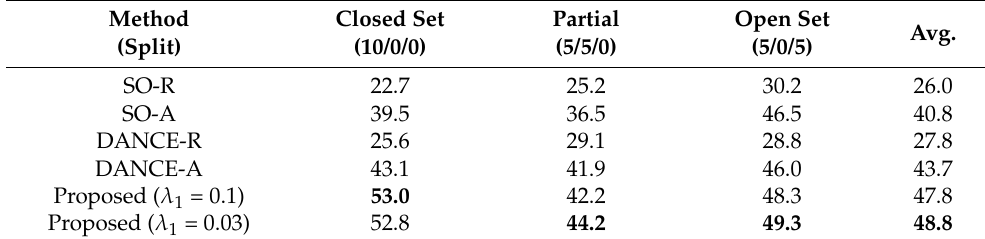
Table 3. Comparison of baselines on MNIST →